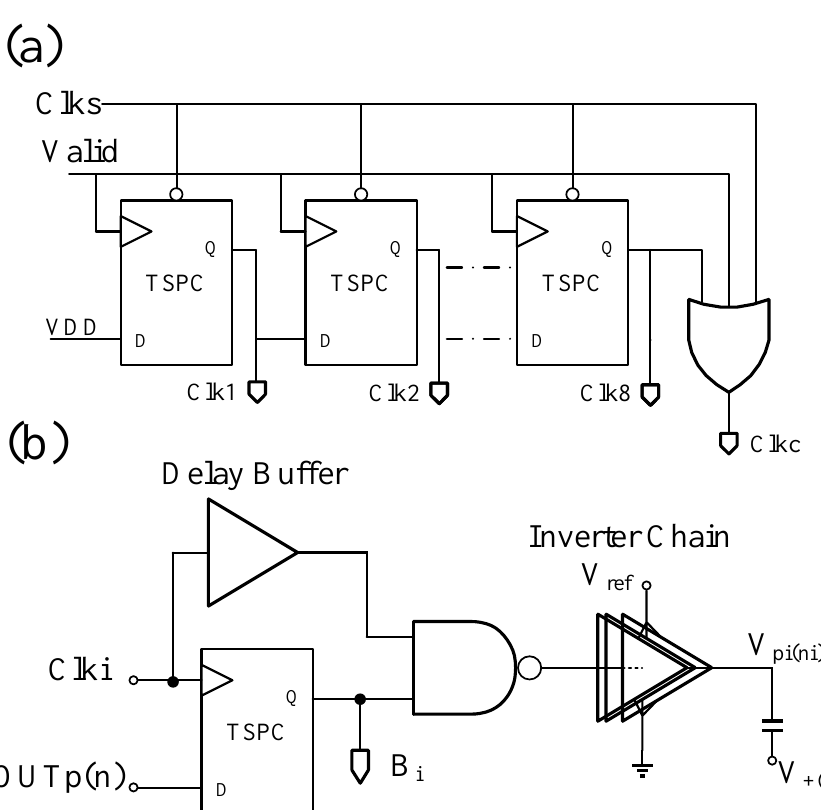
Figure 13. ( a ) Schematic of asynchronous control logic, ( b ) the control logic of